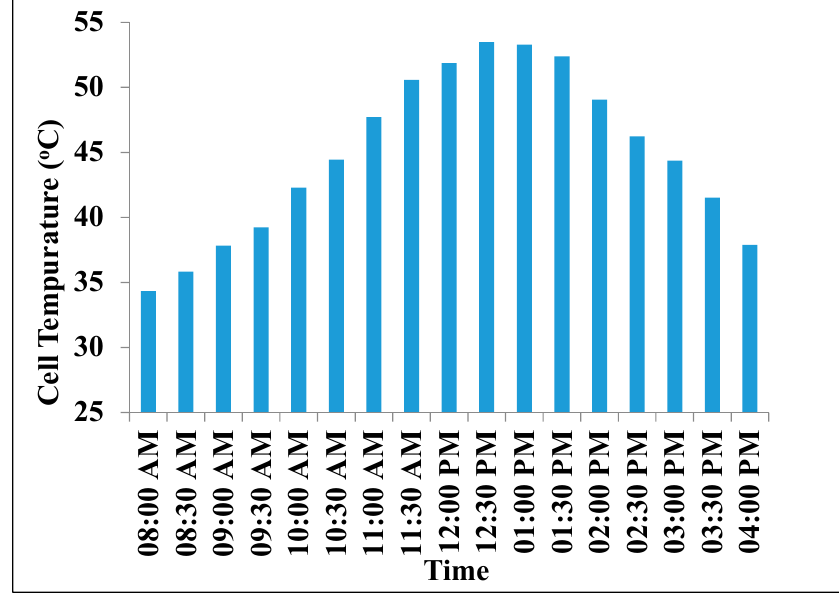
Figure 4. Variation of PV cell temperature of PVT system with time during the day, 15 May 2017.